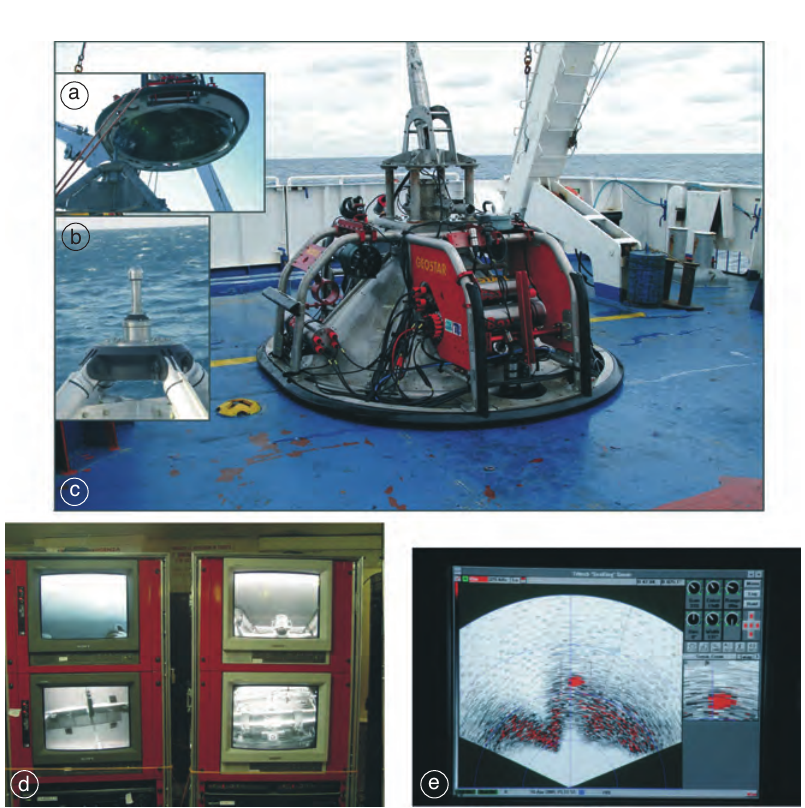
Fig. 3a-e. MODUS, the GEOSTAR deployment/recovery vehicle: a) docking cone and b) pin; c) MODUS on the deck of R/V Urania; d) MODUS on-board console; e) Bottom Station signature displayed on the sonar monitor.